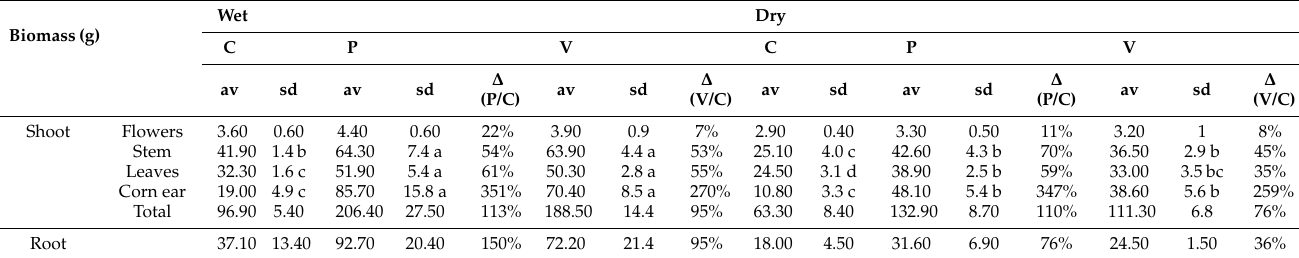
Table 5. Dry biomass (g per plant) of the shoot (separated in flower, stem, leaves and corn ears) and root at harvesting (70 DAP), in the wet and dry treatments (i.e., columns in which matric potential maintained close to − 150 and − 500 hPa respectively) for the unamended control, compost and vermicompost added